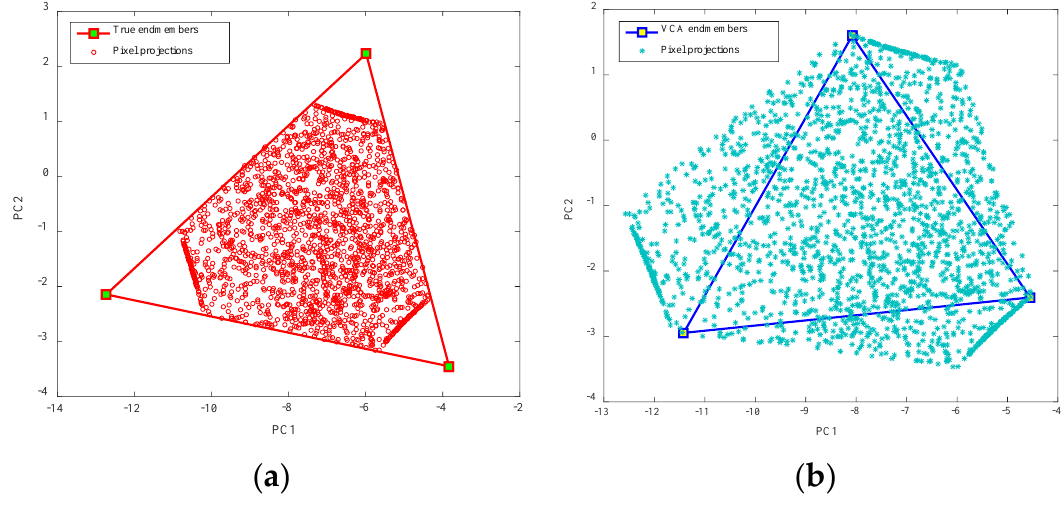
Figure 6. The impact of the accuracy of endmembers on projections: ( a ) true endmembers; ( b ) vertex component analysis (VCA) endmembers.